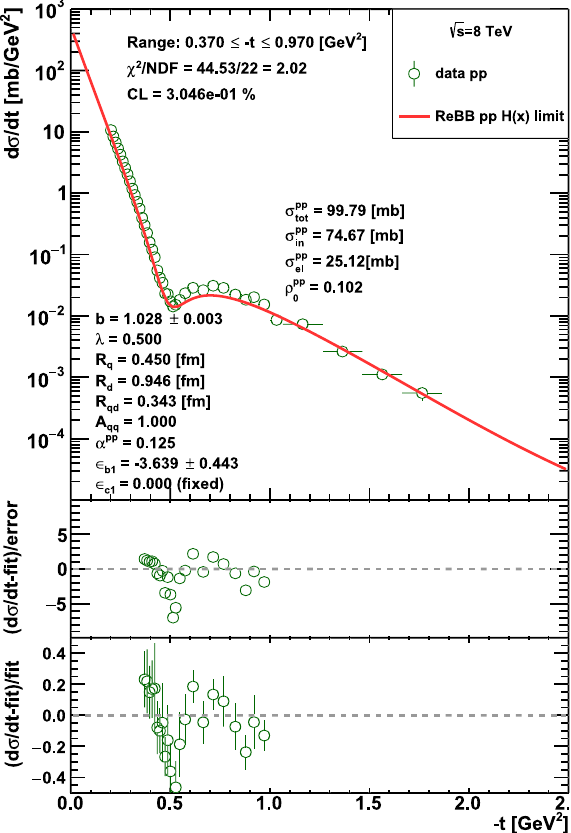
Fig. 4 The H ( x ) scaling limit of the ReBB model compared to the pp 8 TeV TOTEM data [15]. Otherwise, same as Fig.